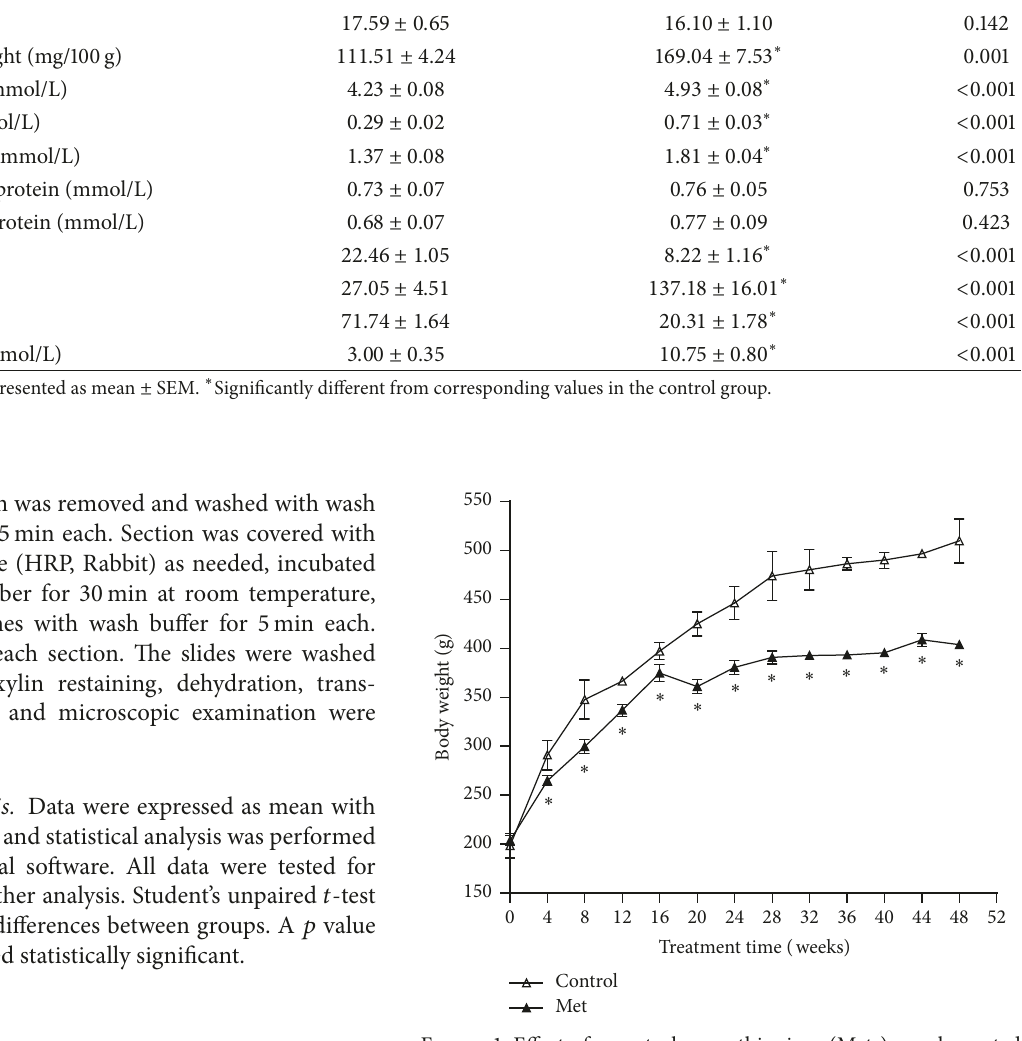
Figure 1: Effect of a control or methionine- (Met-) supplemented dietonchangeinbodyweightinMet-dietgroup( 𝑛 = 6 )andcontrol- dietgroup( 𝑛 = 6 ).Valuesaremean ± SEM.MeanvaluesfortheMet- diet group were significantly different from those of the control-diet group. ∗ 𝑝 < 0.05